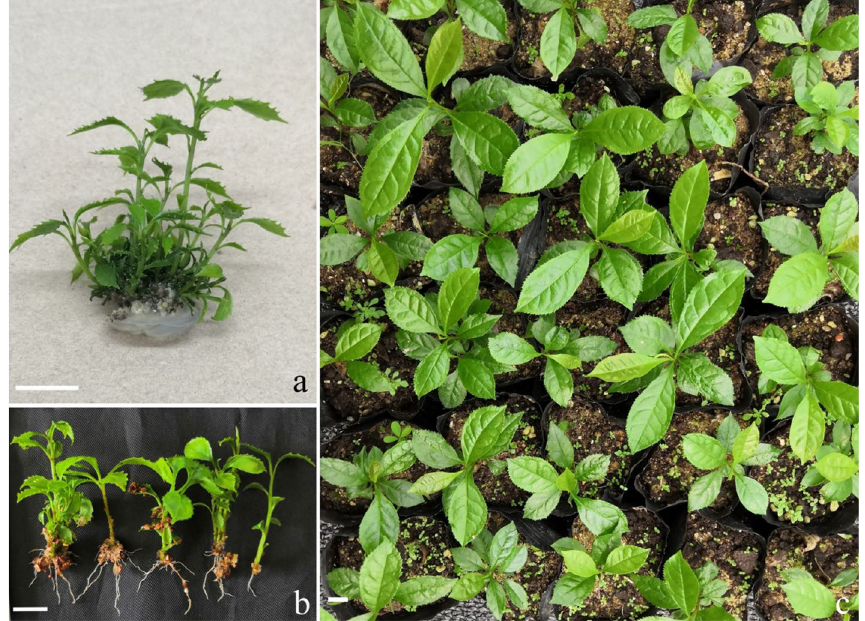
Figure 4. Adventitious shoot growth, rooting and transplanting in Euryodendron excelsum. ( a ) Callus clumps with adventitious shoots which was derived on WPM supplemented with 1.0 mg/L 2,4-D for 5 weeks then transferred to WPM supplemented with 1.0 mg/L BA for 5 weeks developed multiple shoots. ( b ) Shoots that were cultured on vermiculite-based WPM with 0.5 mg/L NAA for 2 months developed roots. ( c ) Plantlets were transferred to plastic bags with peat: sand (1:1, v/v ) for three months. Bars = 1.0